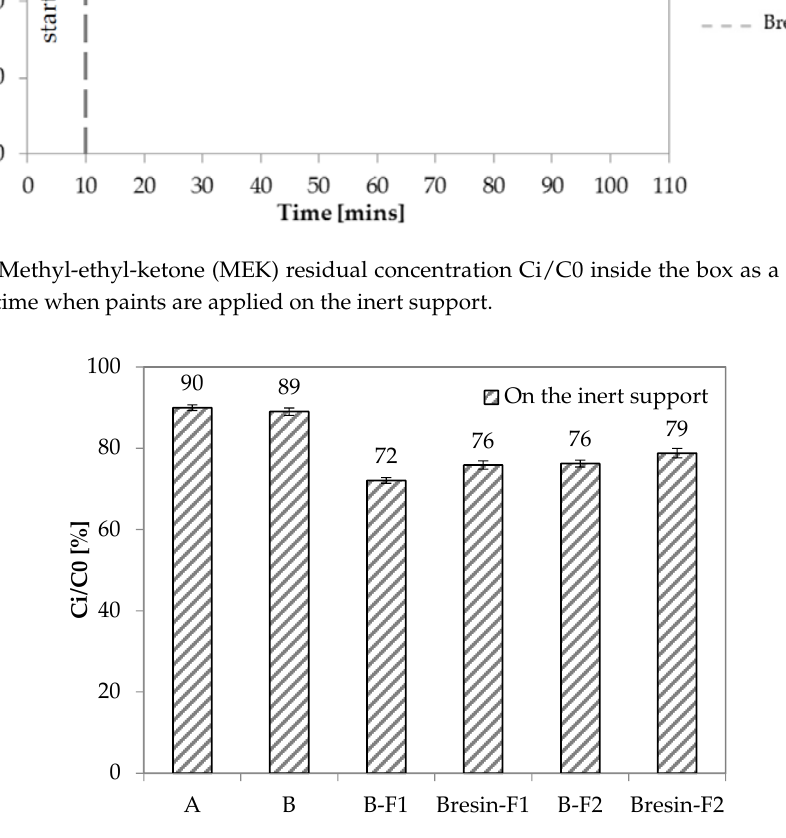
Figure 8. Depollution capacity in terms of MEK residual concentration Ci/C0 inside the box after 120 min.